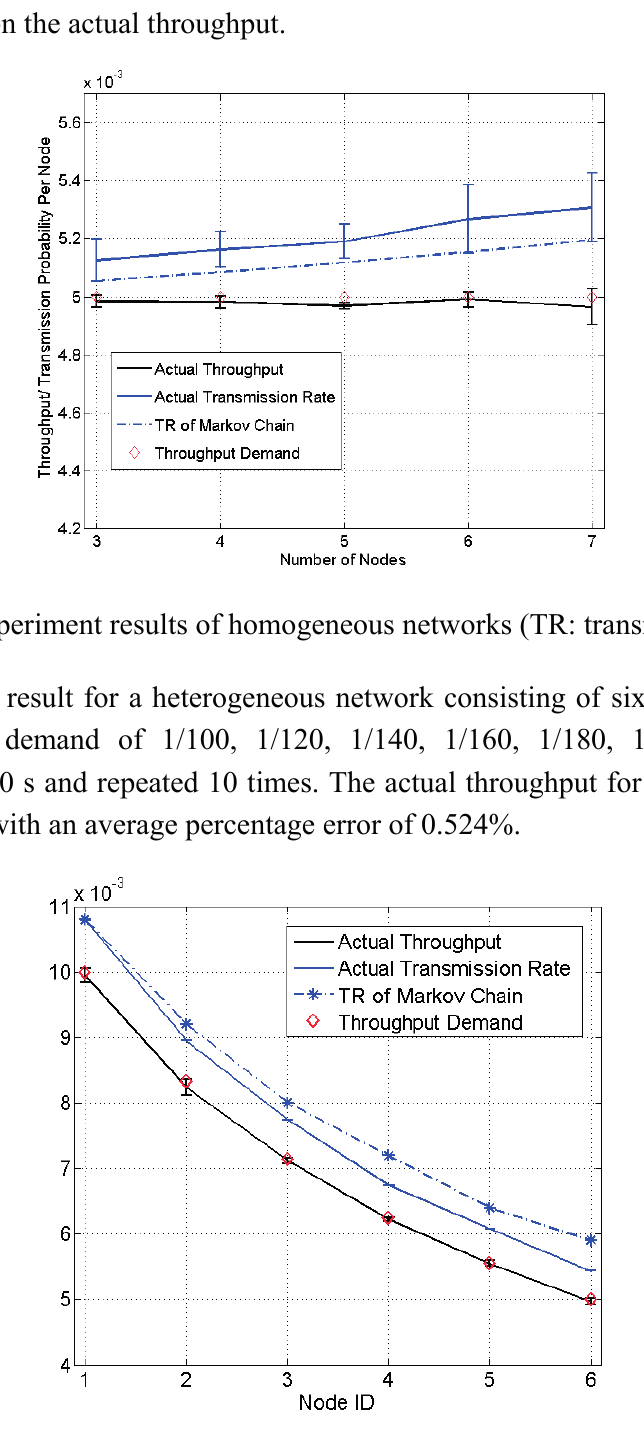
Figure 7. Experiment results of heterogeneous networks (TR: transmission